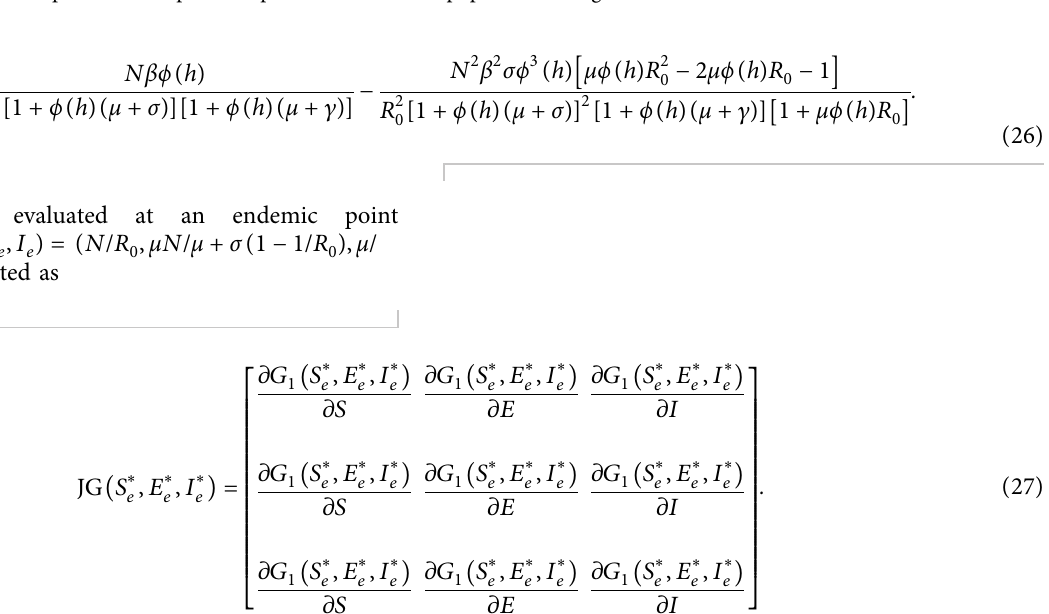
Figure 3: Time plots of susceptible, exposed, and infected population using the NSFDPC method with h � 0 . 01